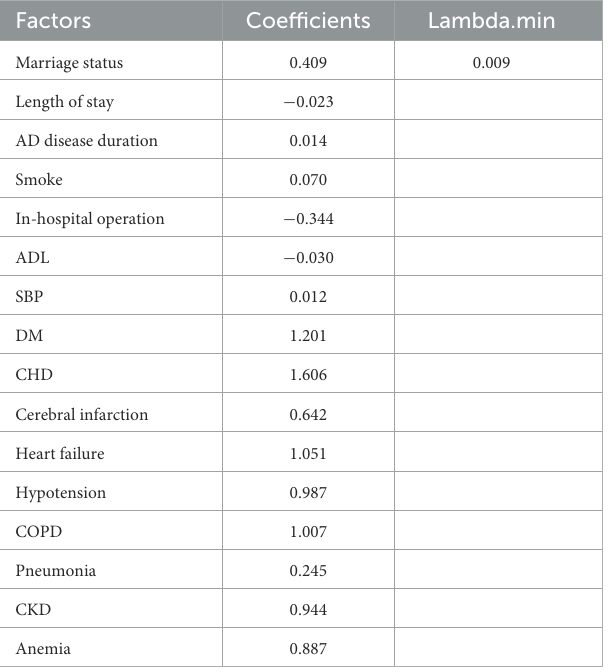
TABLE 2 Coefficients and lambda.min value of the LASSO